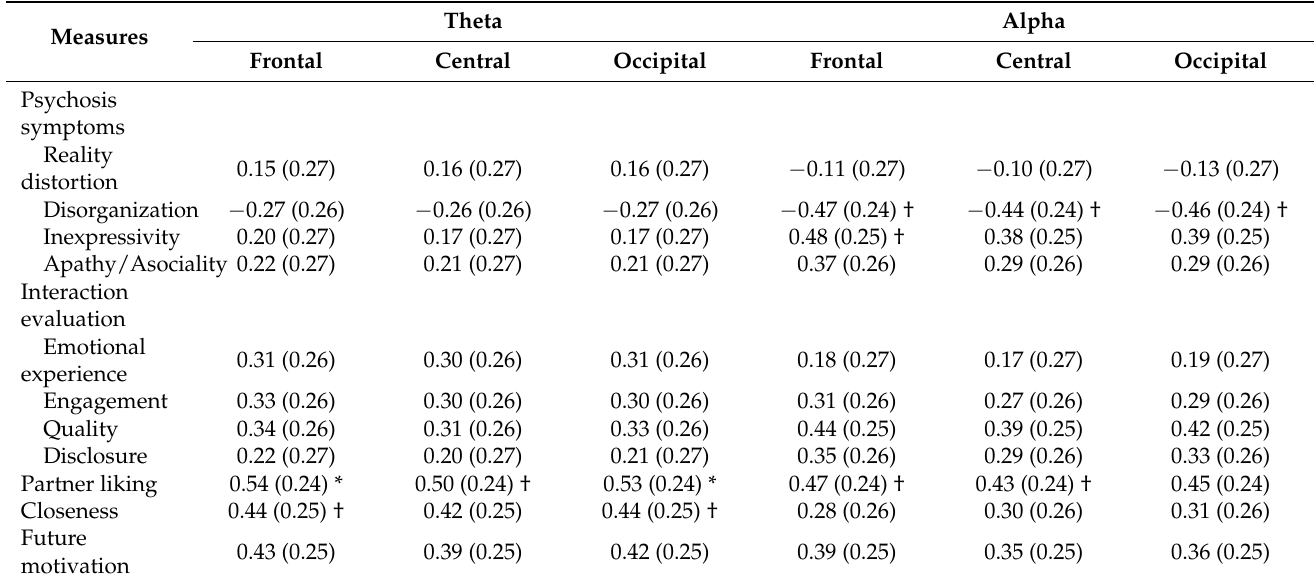
Table 3. Standardized simple slope (standard error) estimates for the association of functional connectivity with symptom and post-interaction ratings in patients.